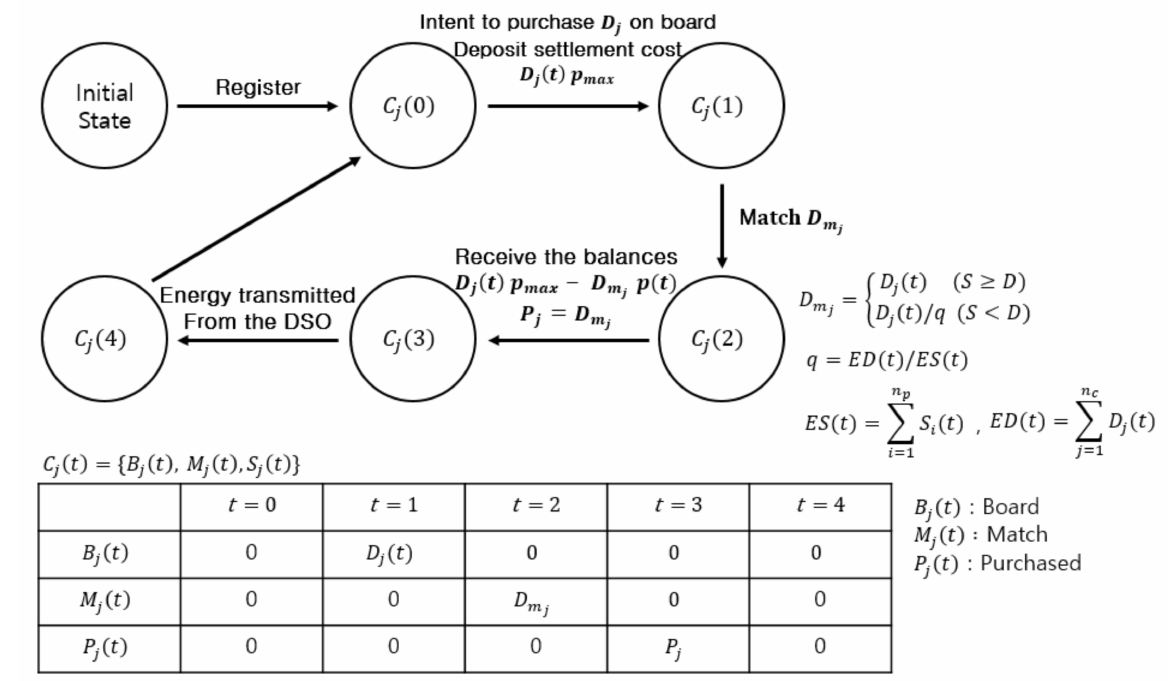
Figure 4. A state diagram for consumer j in phase t = 0, 1, 2, 3 and 4 of energy